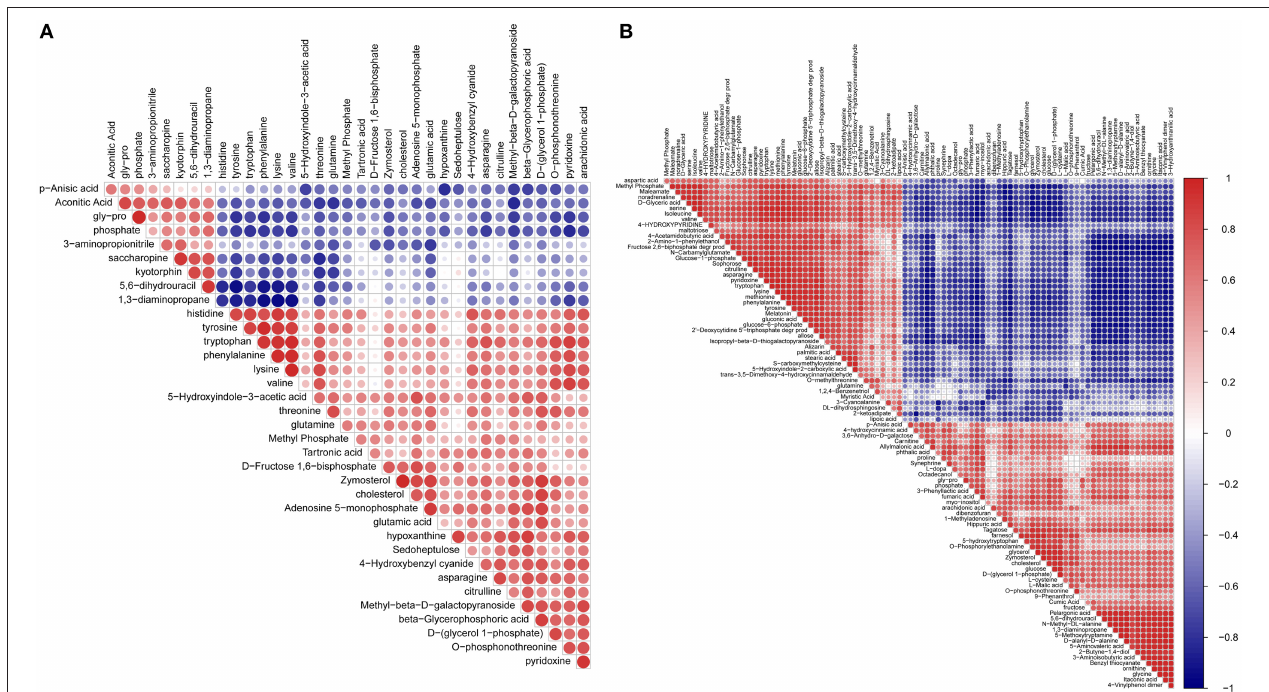
FIGURE 4 | Metabolites-metabolites correlation analysis. Positive correlations are shown in red; negative correlations are shown in blue. (A) Metabolites-metabolites correlations of 2DG vs. TCPS. (B) Metabolites-metabolites correlations of 3DG vs.